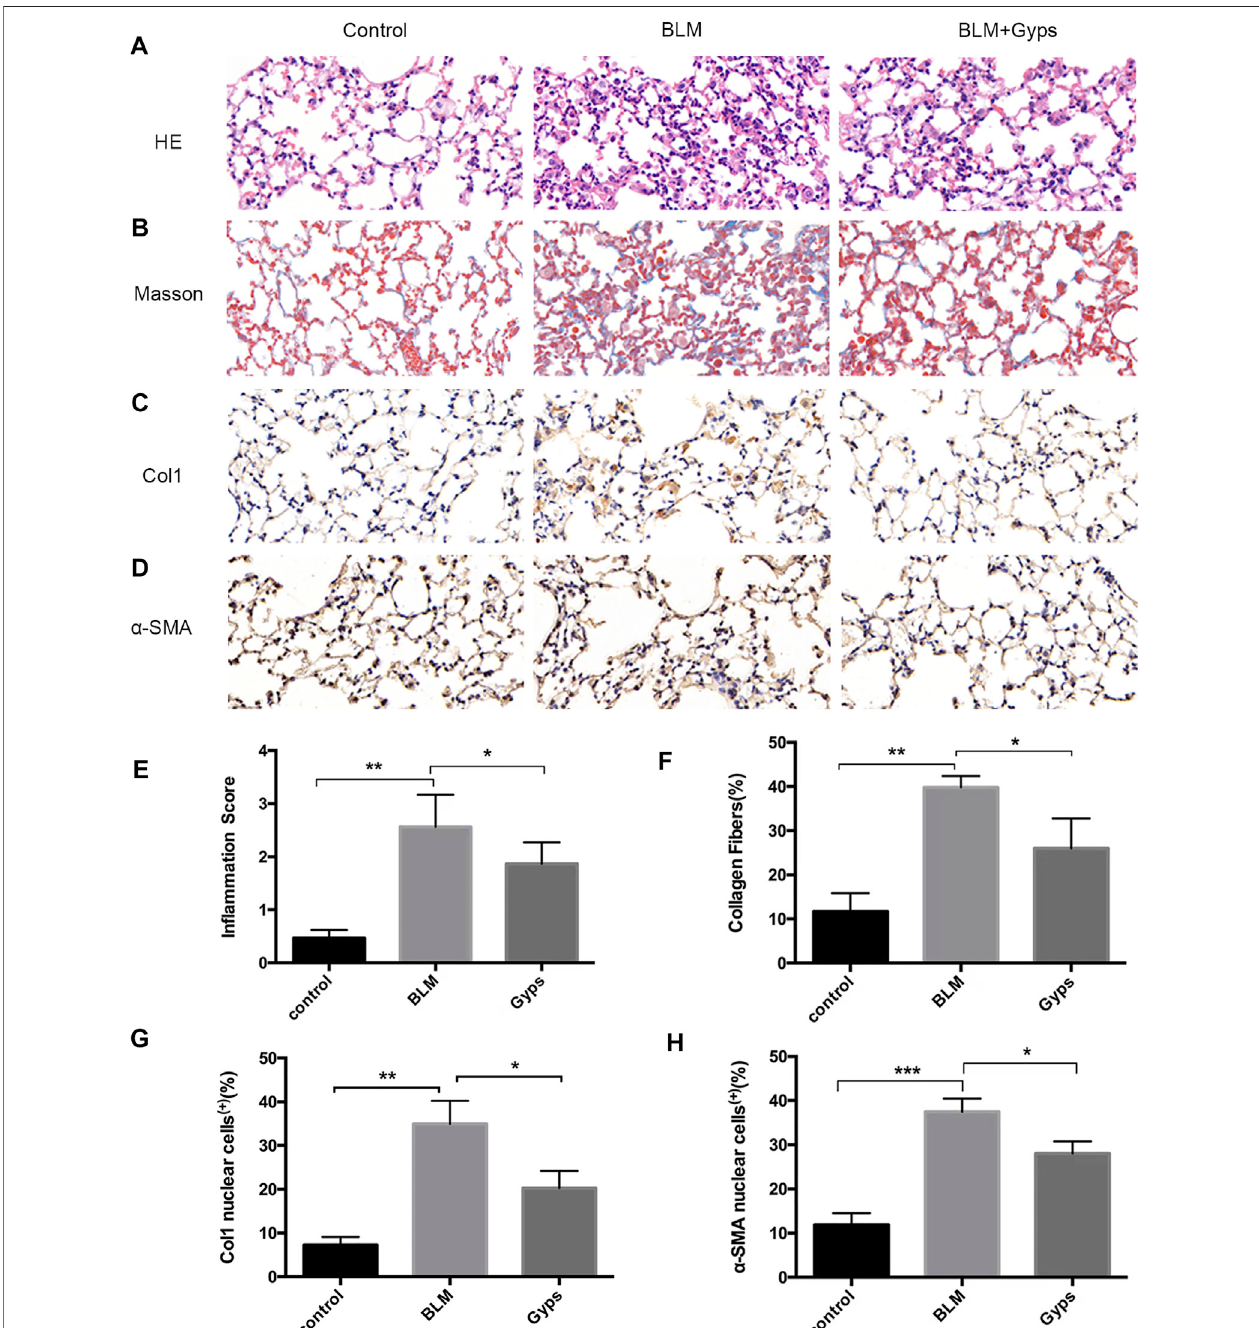
FIGURE3| EffectsofGypsonpulmonaryin fl ammationand fi brillation. (A,B) RepresentativeimagesofHEandMasson ’ sstainingoflungtissuesections(400 × ). (C, D) Immunohistochemistry was used to analyze the expression levels of Col1 and α -SMA (400 × ). (E – H) Quantitation of the data presented in panel (A – D) . Gyps (cid:1) gypenosides, BLM (cid:1) bleomycin. *** p < 0.001, ** p < 0.01, compared with control; * p < 0.05 compared with BLM.